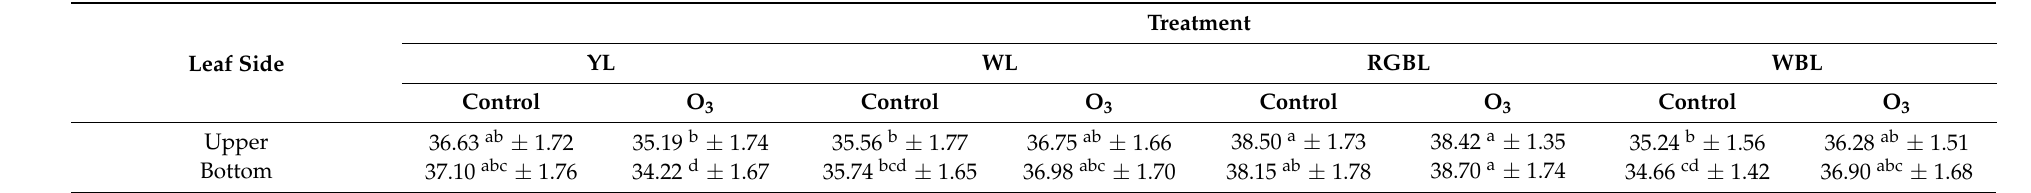
Table 4. Total chlorophyll content measured with a SPAD chlorophyll meter on the upper and lower sides of Brassica rapa subsp. pekinensis growing in different light spectrums and treated with ozone (100 ppb, 21 days) or non-fumigated (control). YL—yellow light (sodium lamp), WL—white light (LED), RGBL— red + green + blue light (LED) and WBL—white + blue light. Average values ( ± SD) marked with the same letters in the row do not differ significantly according to Duncan’s test, p ≤ 0.05, n =